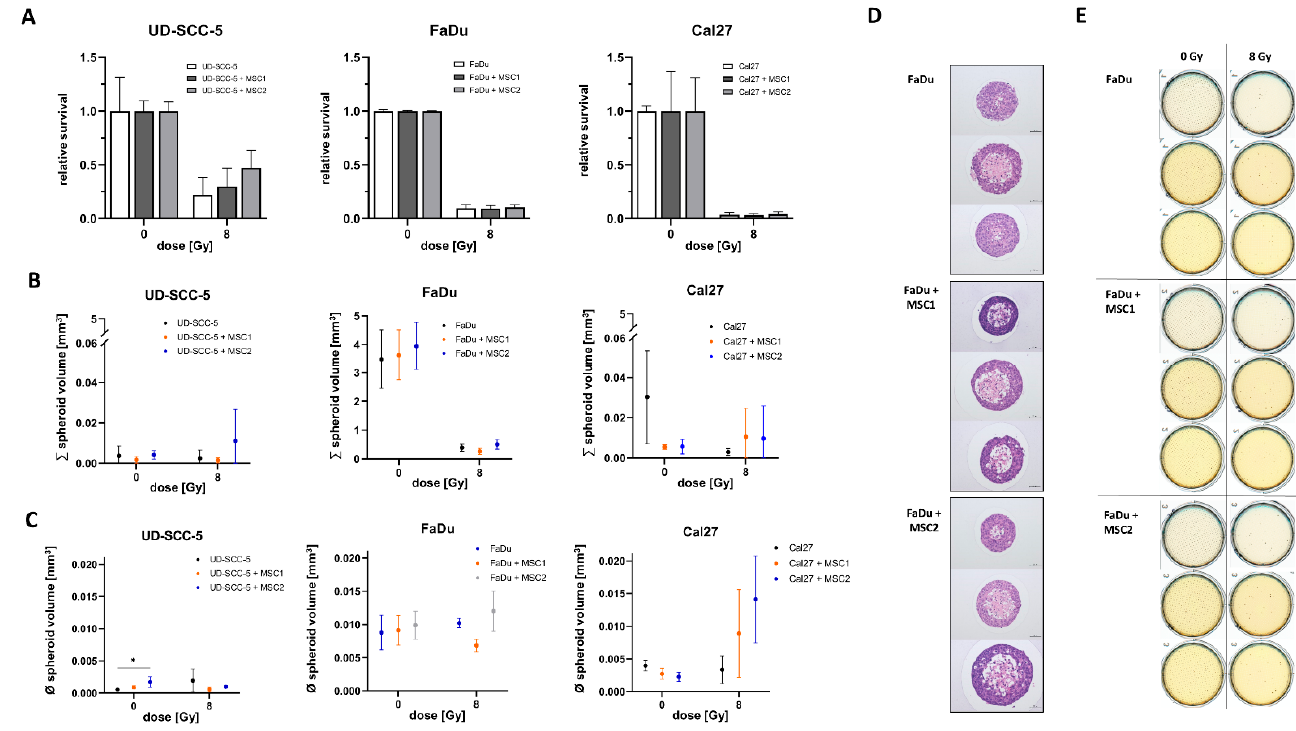
Figure 3. Direct three-dimensional MSC-HNSCC co-culture reveals no radioprotective effects of MSCs. ( A ) Relative survival after irradiation with 8 Gy in HNSCCs mono-culture and HNSCC-MSC co-culture. By comparing HNSCC mono-cultures with HNSCC-MSC co-cultures using one-way ANOVA with post-hoc Dunnett’s tests, no radioprotective or radiosensitizing effects could be ob- served. ( B ) Sum of all spheroids within the conical agarose microwell arrays at 0 Gy and 8 Gy. One- way ANOVA tests revealed no differences between HNSCC mono-culture and HNSCC-MSC co- cultures. ( C ) Average spheroid volume of HNSCC mono-culture and HNSCC-MSC co-cultures after 0 Gy and 8 Gy. * p < 0.05 (one-way ANOVA with post-hoc Dunnett’s tests). ( D ) Representative im- ages of hematoxylin and eosin stainings. ( E ) Representative scans of the HNSCC and HNSCC-MSC conical agarose microwell arrays after 0 Gy or 8 Gy, showing the anti-proliferative effects of 8 Gy irradiation on the cell aggregates.